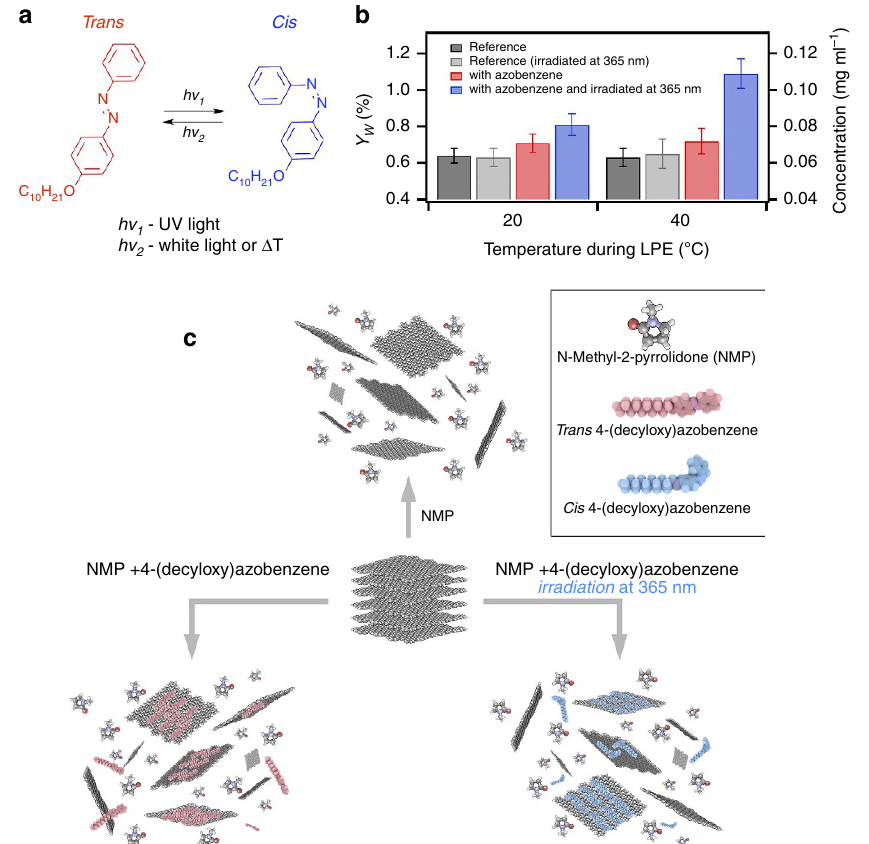
Figure 1 | Light-assisted graphene’s LPE process in the presence of 4-(decyloxy)azobenzene and yield of exfoliation. ( a ) Chemical structure of 4-(decyloxy)azobenzene and reversible trans – cis photoisomerization under UV and visible light. ( b ) Y W and concentration after filtration. The error bars reflect a statistical analysis on 20 independent experiments. ( c ) Schematic representation of the LPE process under different experimental conditions: in NMP (reference experiment); and in NMP with azobenzene in dark and under UV